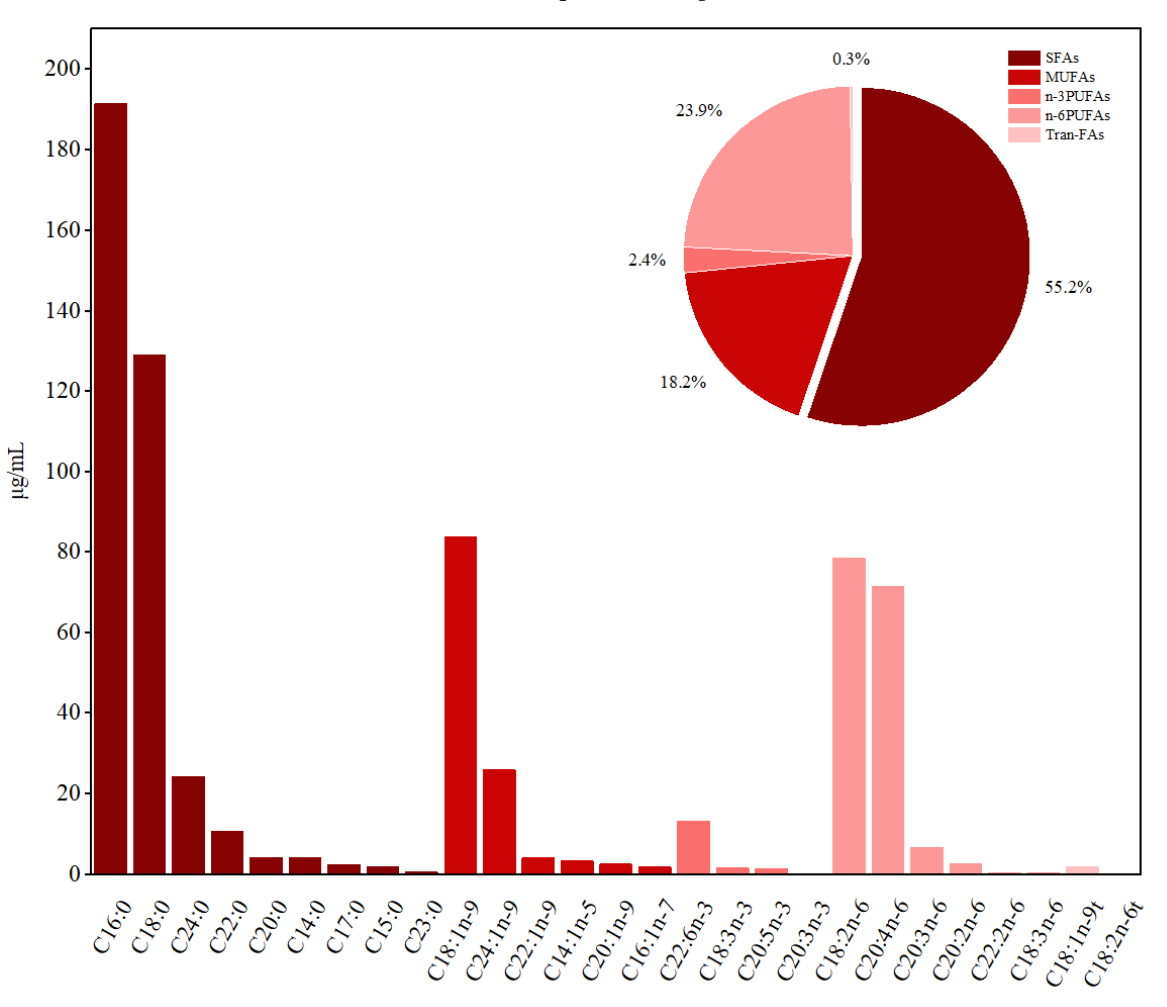
Figure 1. The concentration and constituent ratio of FAs in erythrocyte among children. Data for the concentration of FAs are presented as mean. Abbreviations: SFAs—saturated fatty acids; MUFAs— monounsaturated fatty acids; PUFAs—polyunsaturated fatty acids; Tran-FAs—tran-fatty